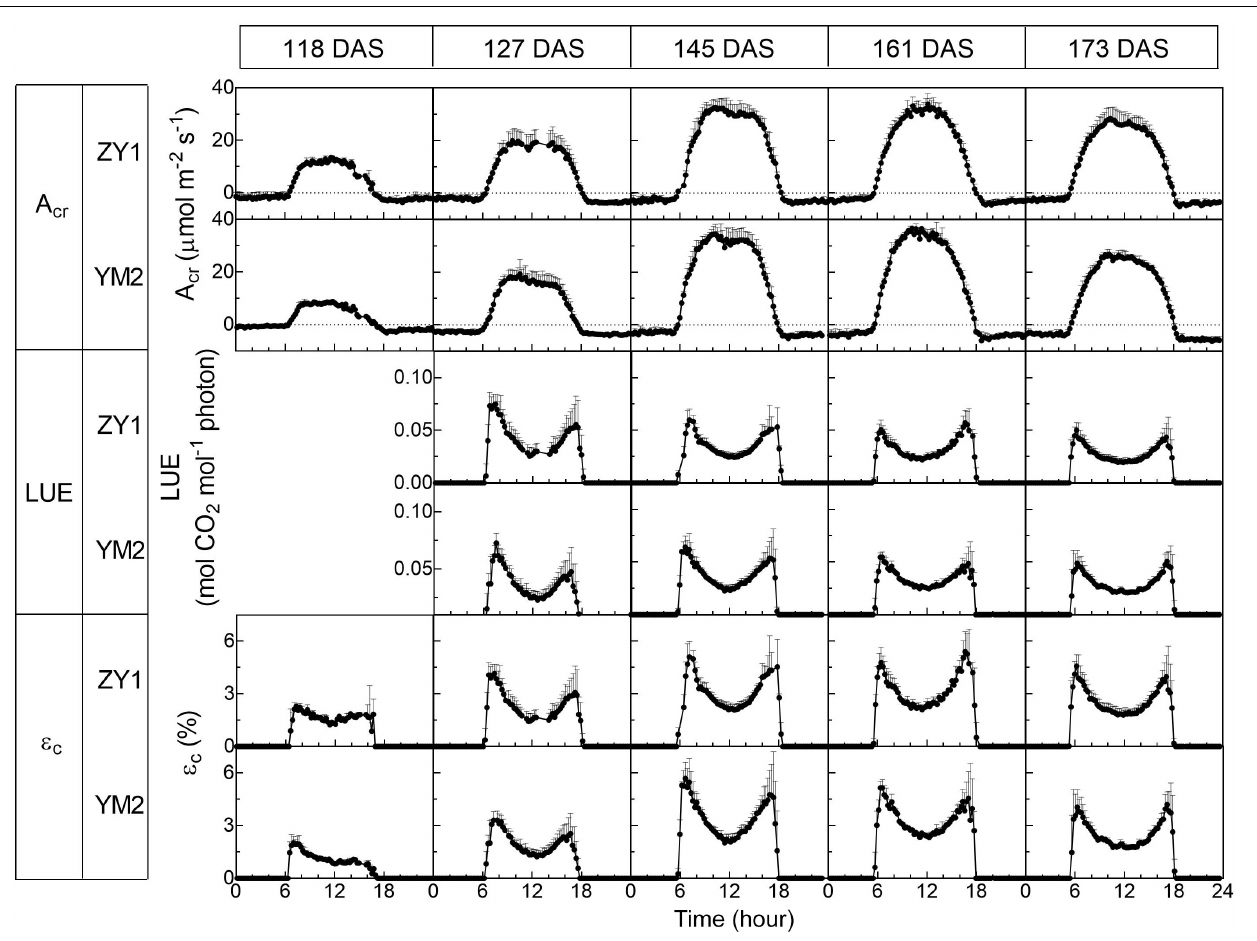
FIGURE 2 | Diurnal changes of the whole plant (canopy plus root) CO 2 flux (A cr ), light use efficiency (LUE), and energy conversion efficiency ( ε c ) of two wheat cultivars, ZY1 and YM2, on different days at five developmental stages, i.e., the tillering (118 DAS), booting (127 DAS), heading (145 DAS), early grain filling (161 DAS), and late grain filling (173 DAS). The measurements were conducted with a multi-CAPTS system. Data are shown as mean ± SD ( n = 3